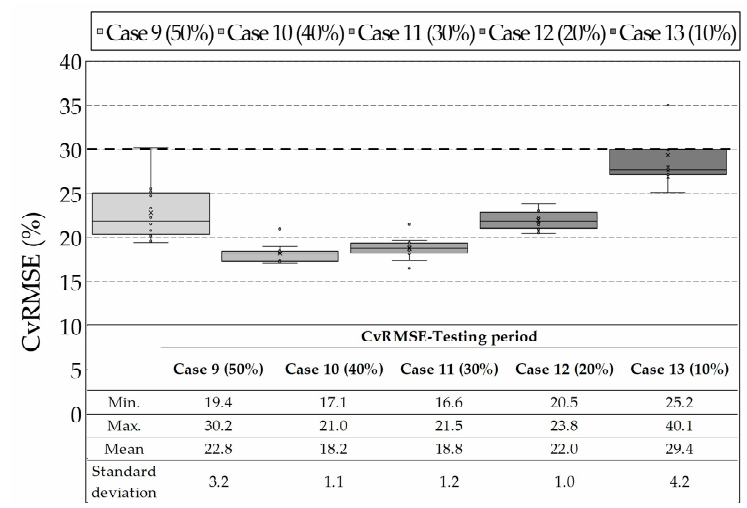
Figure 6. Accuracy according to the changes in proportion of the testing data for the testing period.